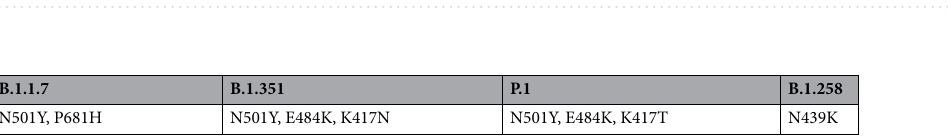
Table 4. A suggestion for the minimum of mutations required for identification of the listed SARS-CoV-2 substrains given the substrains present in Denmark from January to May 2021.